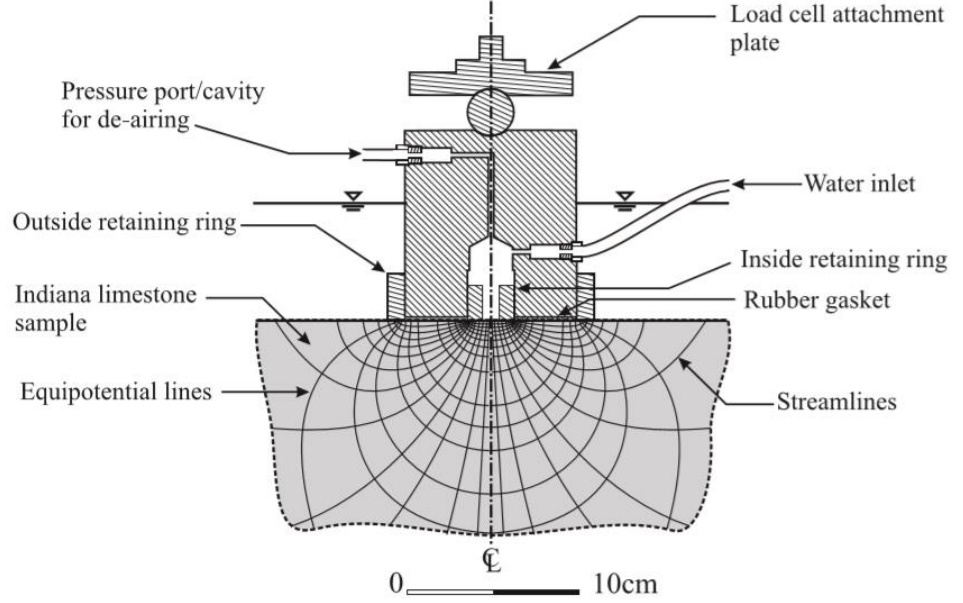
Figure 3. The surface permeameter [99].